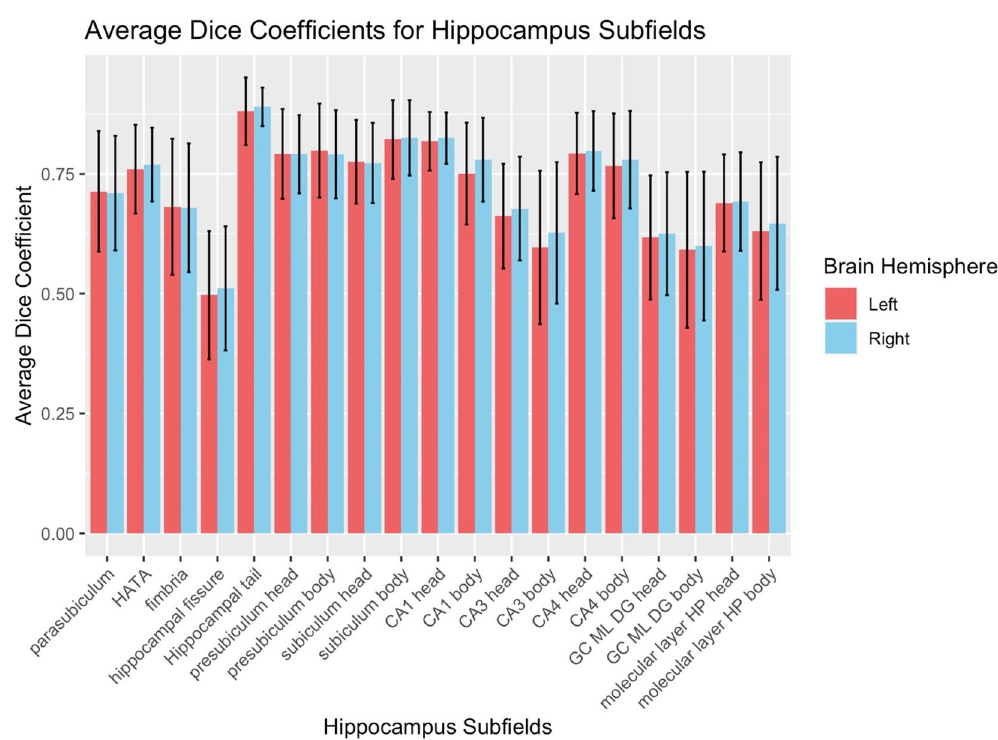
Fig. 2 Hippocampal Dice coefficient values for all hippocampal subfields. Error bars represent 1 standard deviation above and below the mean. Subfield Abbreviations include: Cornu Ammonis CA , Granule Cell and Molecular Layer of Dentate Gyrus GC-ML-DG , Hippocampus-Amygdala-Trans ition-Area HATA , Hippocampal Parcellation